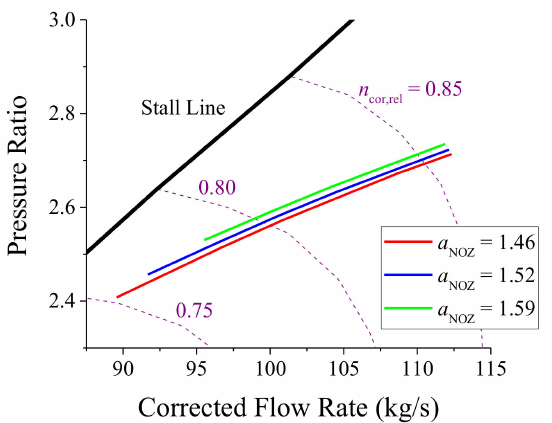
Figure 27. The Variations of the Matched Operating Lines of Front Fan at the conditions of Different Throat Area Coefficients of Main Nozzle ( α NOZ